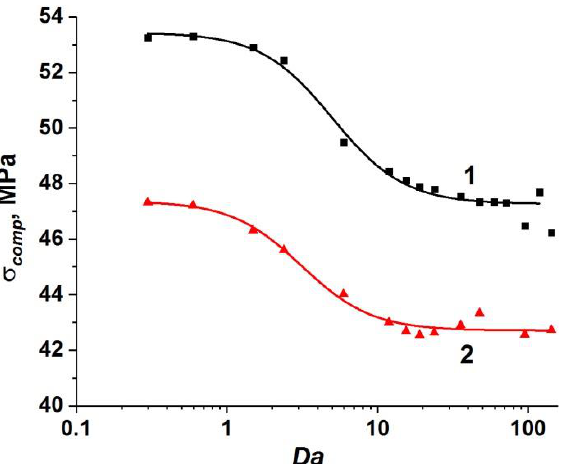
Figure 10. Dependence of the compressive strength of water-saturated concrete samples with the same microporous structure but different spatial arrangements of aggregates. Curves 1 and 2 correspond to the samples in Figure 9a,b.